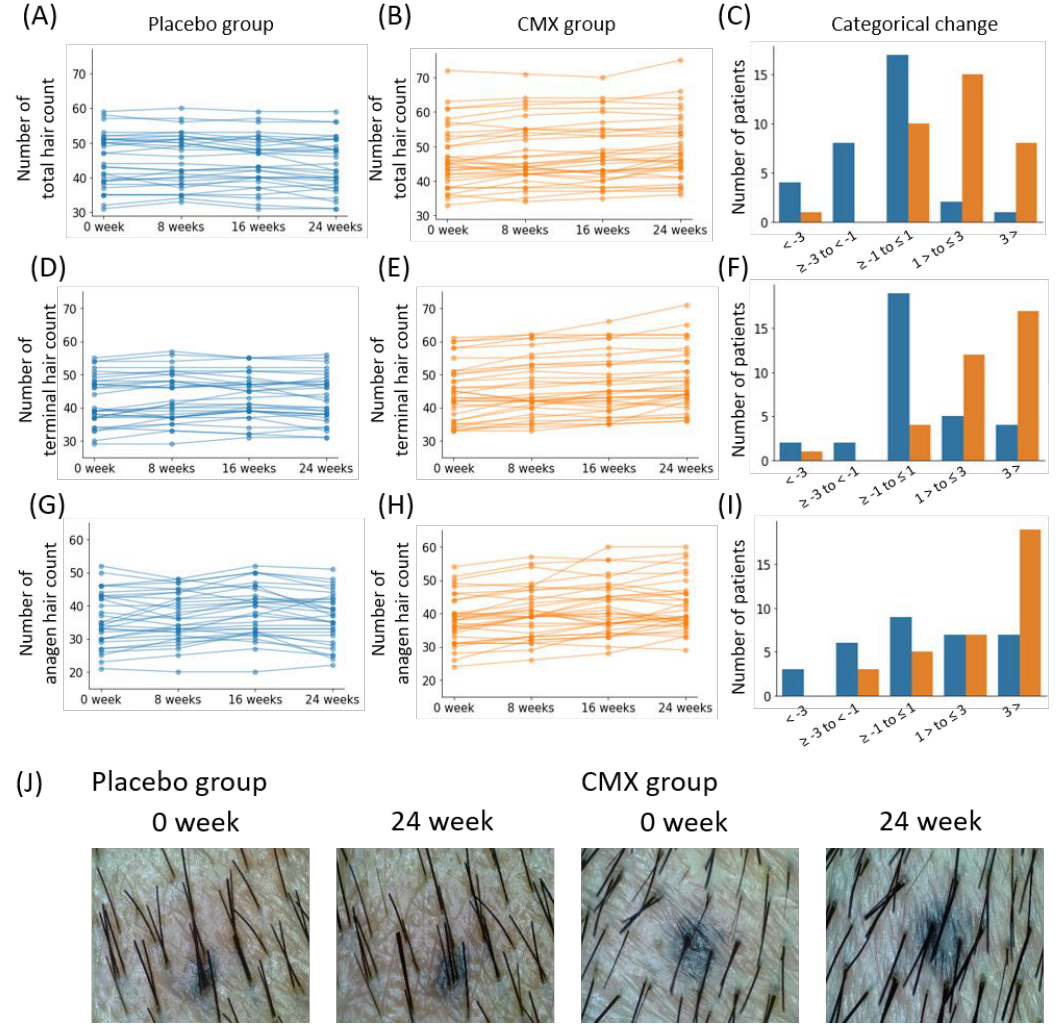
Figure 5. Hair count change and categorical change. Changes in total hair ( A , B ), terminal hair ( D , E ), and anagen hair ( G , H ) counts. Each point indicates the value of each patient. Categorical changes in total hair ( C ), terminal hair ( F ), and anagen hair ( I ) counts from the baseline to 24 weeks in subjects treated with CMX (n = 34) or placebo (n = 32). Representative macrophotographs of the scalp area at week 0 and week 24, for Placebo group and CMX group ( J ). CMX, emulsion extract of brevilin A from Centipeda minima .